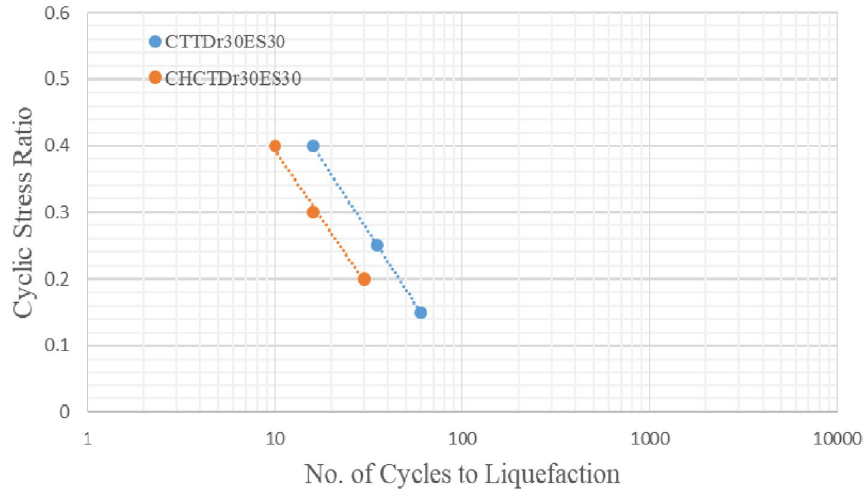
Figure 18. Stress ratio vs number of cycles to liquefaction for samples (Dr 30% FC0ES30) in CTT and CHCT.